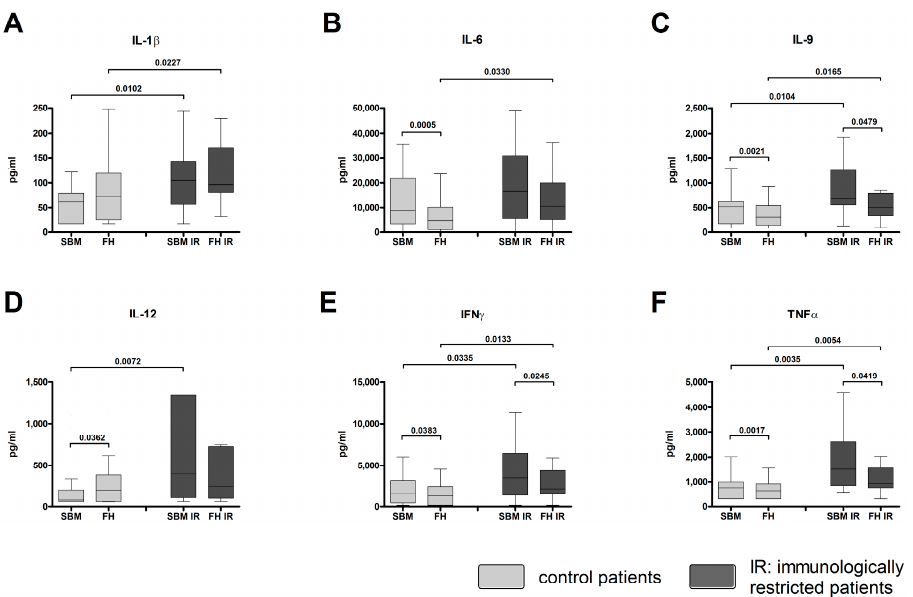
Figure 2. Pro-inflammatory cytokines are found at high concentrations in FH/SBM of immunologically restricted patients (FH IR/SBM IR). Supernatants from FH and SBM of immunologically restricted patients (FH IR/SBM IR: dark grey) and controls (FH/SBM: light grey) were analyzed for the concentrations of pro-inflammatory cytokines via multiplex suspension array. ( A ) Interleukin (IL)-1 β ; ( B ) IL-6; ( C ) IL-9; ( D ) IL-12; ( E ) Interferon γ (IFN) γ ; ( F ) Tumor necrosis factor α (TNF α ). Controls n = 42, IR patients n = 20. IR-patients vs. controls Mann-Whitney U test, FH vs. corresponding SBM Wilcoxon test, p -values < 0.05 are shown as numbers in the Figure. 2.3. Regulatory Cytokines Are Increased at Fracture Sites of Immunologically Restricted Patients When